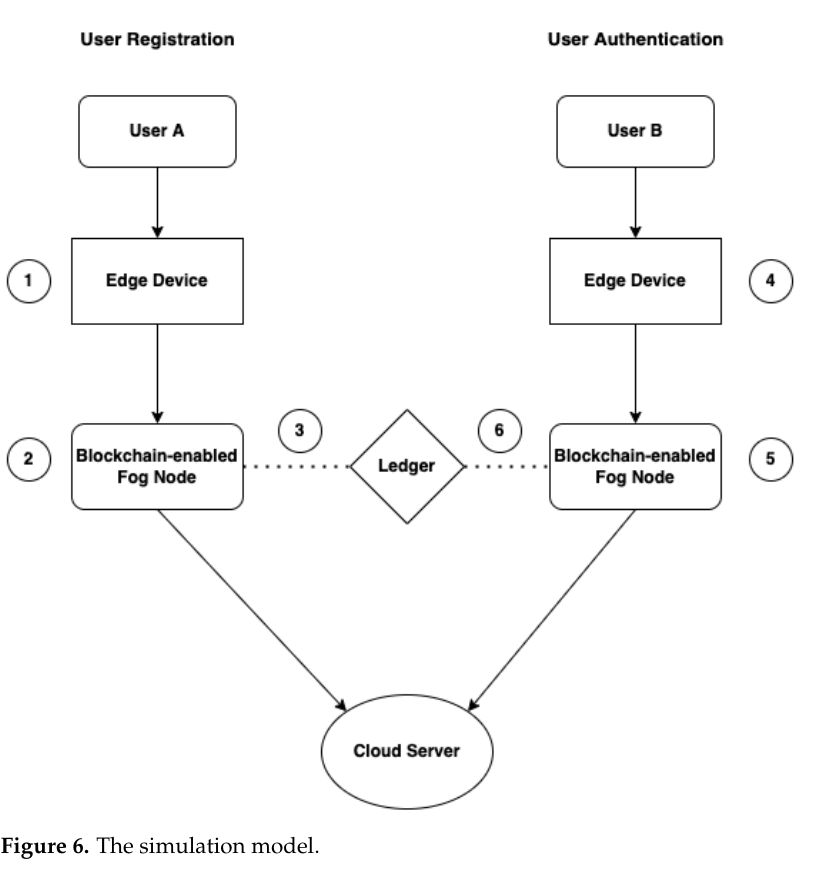
Figure 6. The simulation